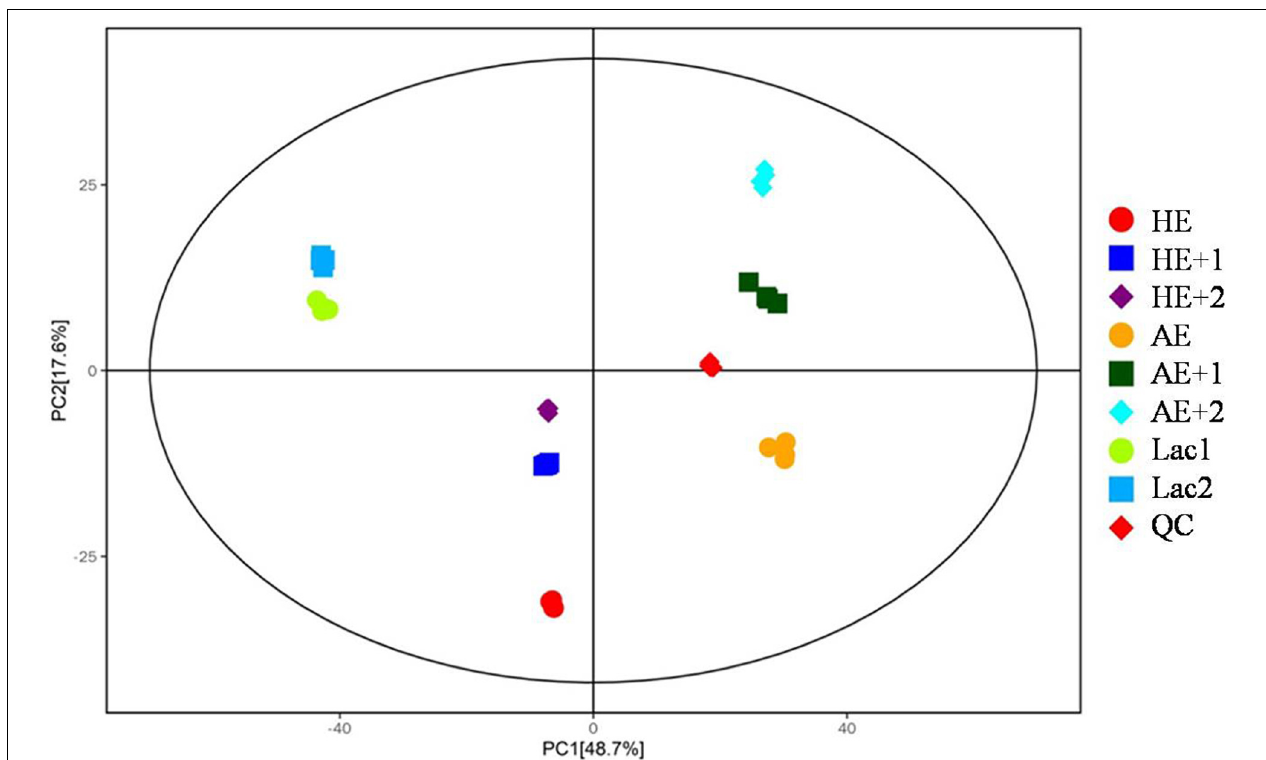
FIGURE 3 | Principal component analysis (PCA) analysis of metabolomic profiles. HE and AE the powders only in MRS medium without bacteria; HE+1, HE+2, AE+1, AE+2, and replicates of addition of HE and AE into the bacterial medium with bacteria; Lac1 and Lac2 replicates of bacterial in MRS medium only as control; and QC, technical